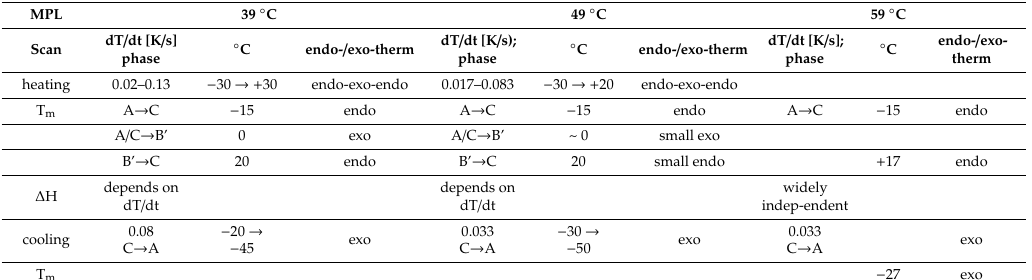
Table 3. Phase transitions of MPL at di ff erent growth